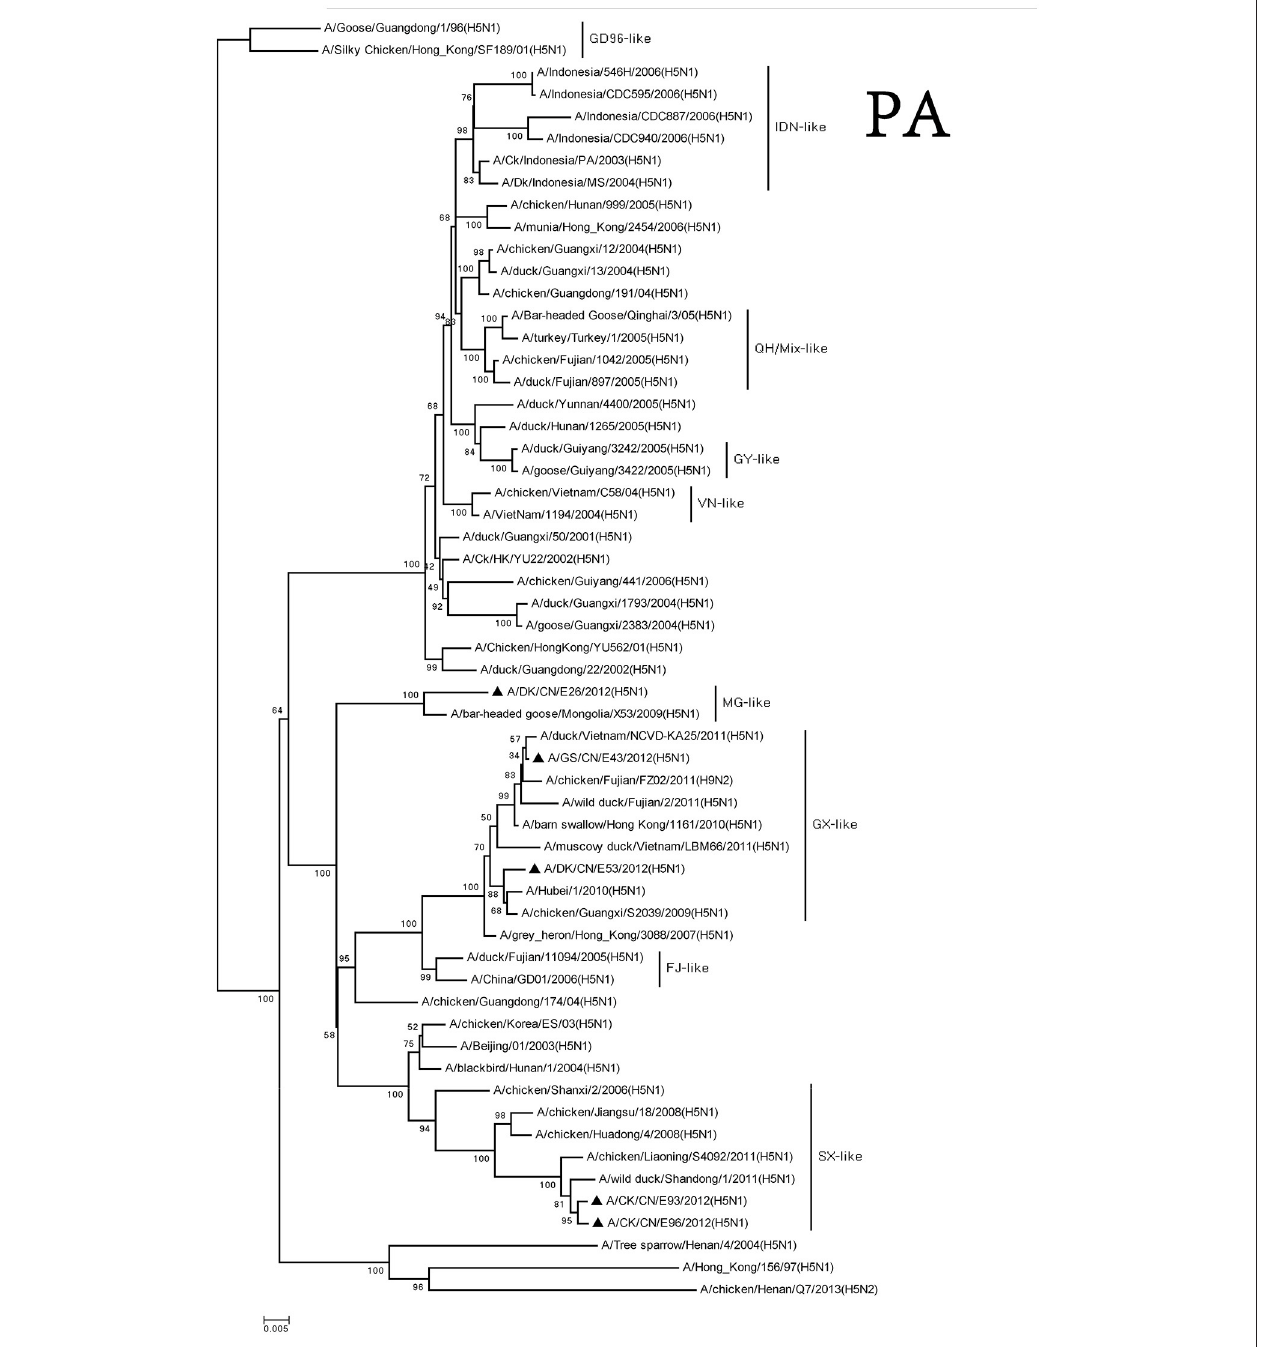
FIGURE 3 | Phylogenetic analysis of PA. PA: nt 25–2,175. Except our isolate, other virus sequences were downloaded from GenBank. QH, Qinghai; VN, Vietnam; IDN, Indonesia; GY, Guiyang; MG, Mongolia; GX, Guangxi; HD, Huadong; SX, Shanxi.